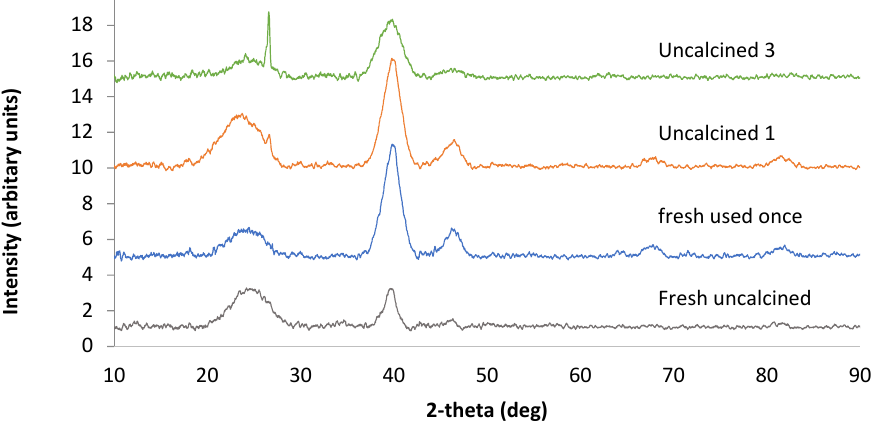
Figure 9. XRD spectra of fresh and used catalysts from one run after calcination and after three runs uncalcined.